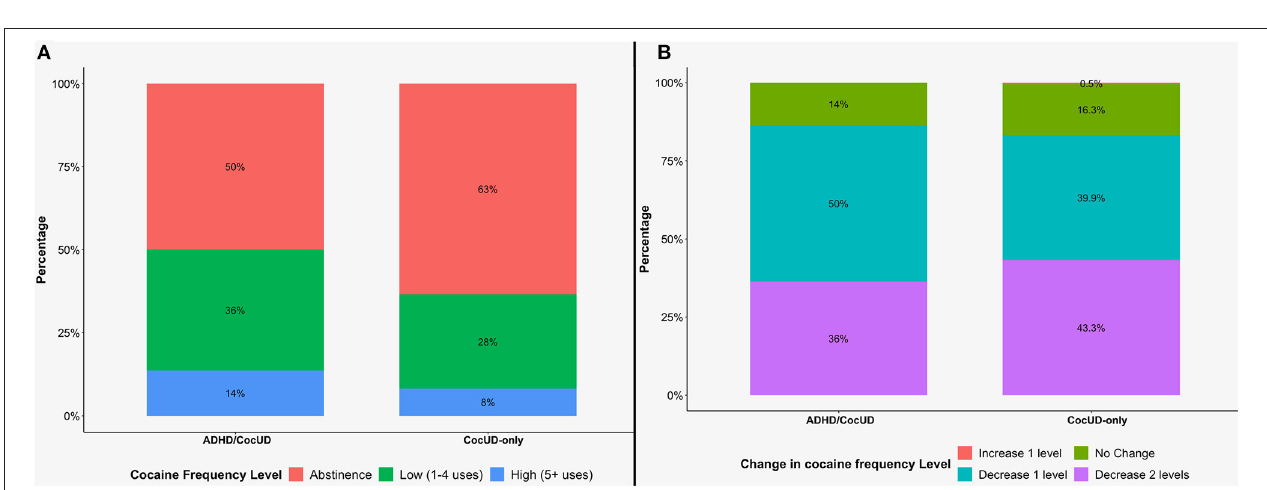
FIGURE 2 | Distribution of patients according to cocaine frequency level at Day 90 (A) , and change in cocaine frequency level in comparison to baseline (B) . ADHD, attention-deficit/hyperactivity disorder; CocUD, cocaine use disorder.